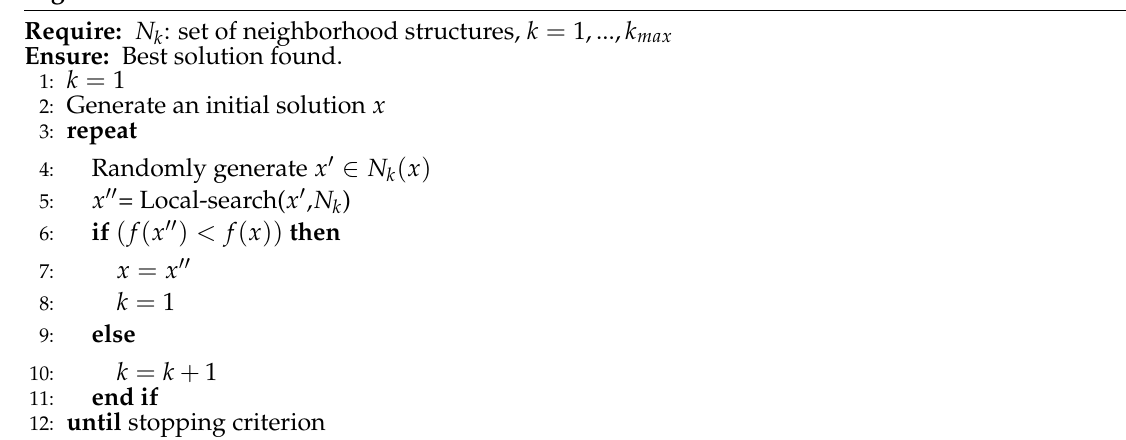
Algorithm 2 Basic